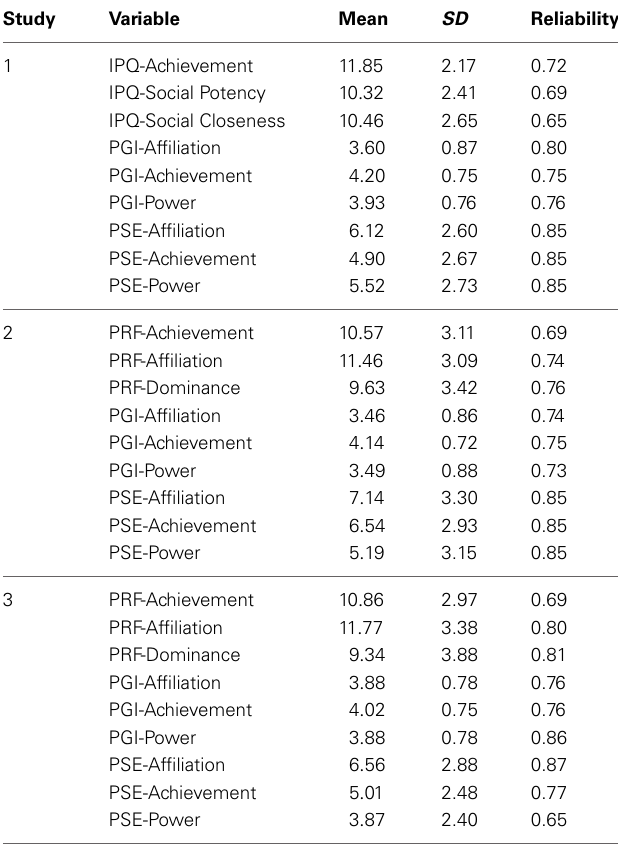
Table 1 | Descriptive statistics and reliabilities for each scale and sample.